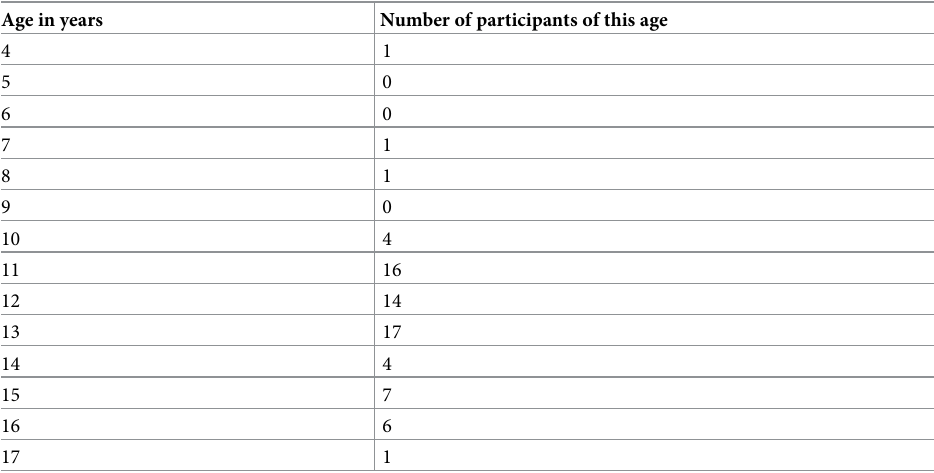
Table 3. Age distribution of the final cohort.